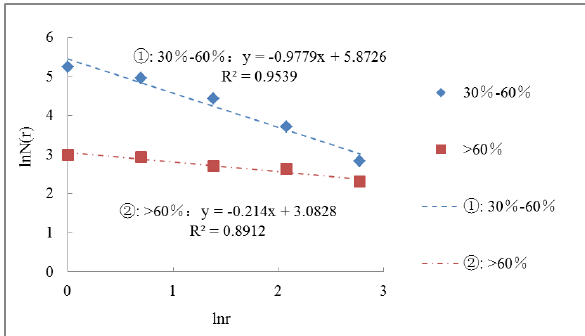
Figure 5. Fitting straight line of lnr-lnN(r) of landslide hazard